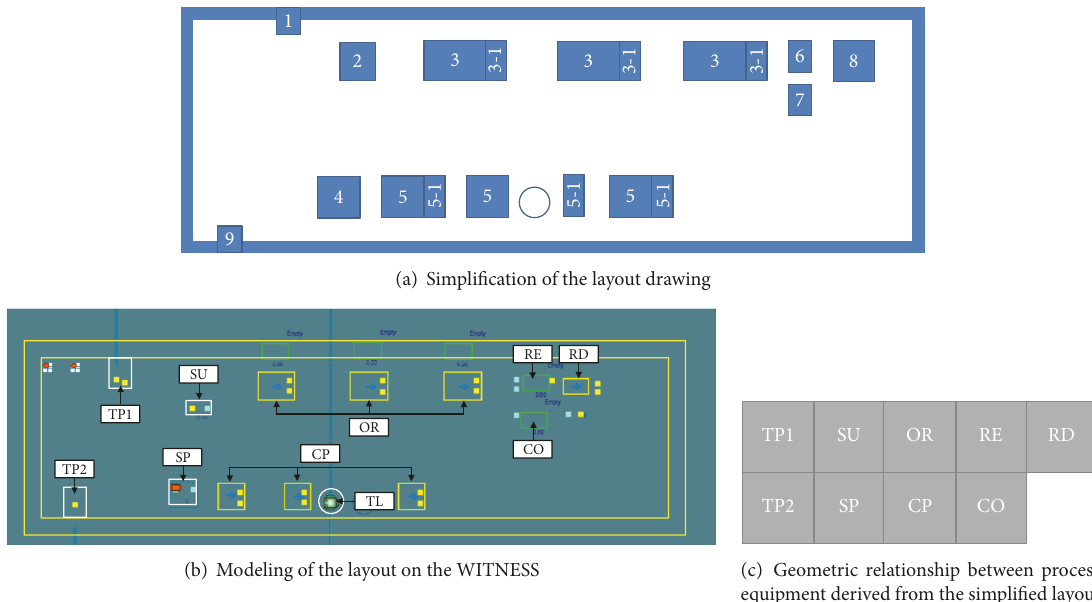
Figure 6: Analysis of the original layout of the considered oxide reduction process cell.